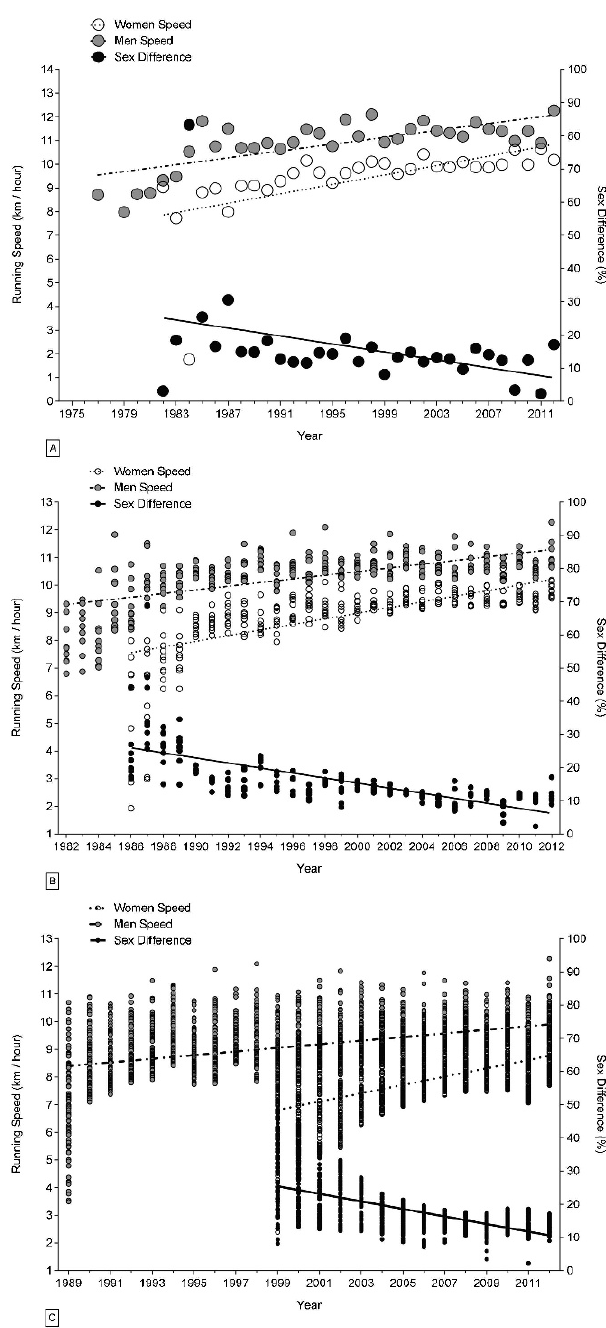
Figure 2 - Changes in running speed and sex differences in running speed for the annual fastest (Panel A), the annual 10 fastest (Panel B) and the annual 100 fastest (Panel C) competitors over (Table 2). When considering the annual 100 fastest finishers, the mean ages remained unchanged at 43.8 ¡ 0.8 years for women and 44.4 ¡ 1.1 years for men (Figure 4C), including when controlling for repeated finishes (Table 2).